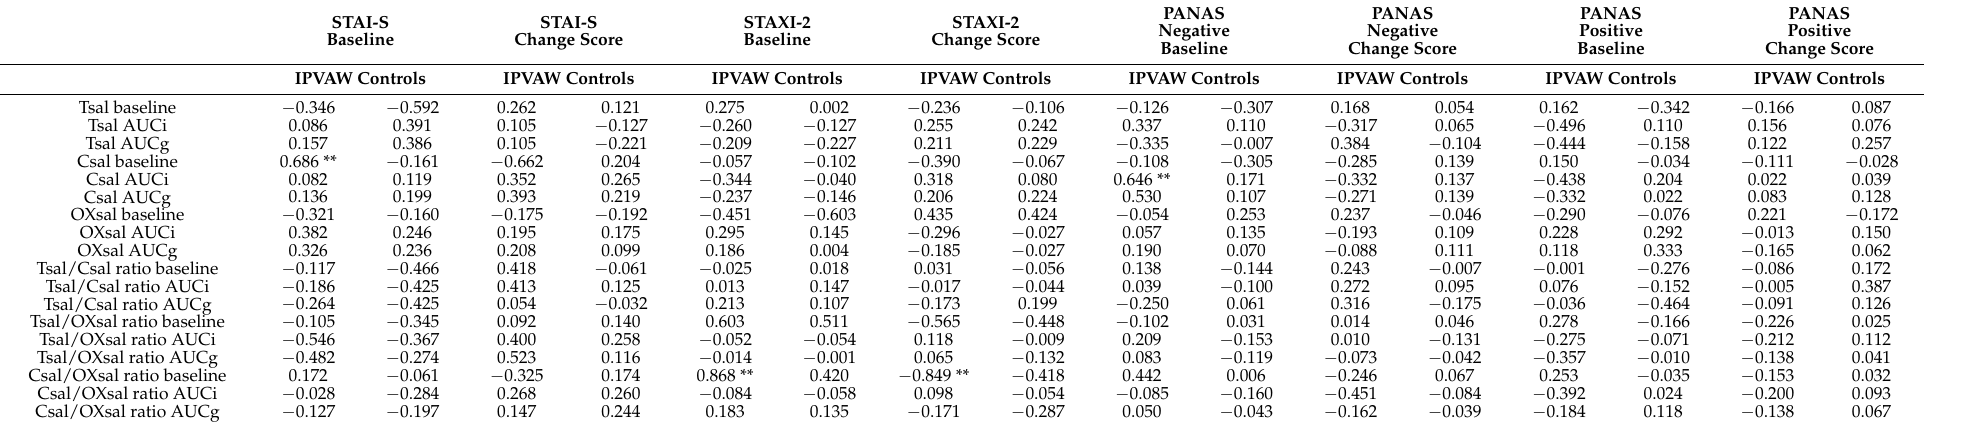
Table 4. Relationships of hormonal variables (baseline and AUC) with psychological state assessment (baseline and change score) for IPVAW perpetrators and controls applying Bonferroni